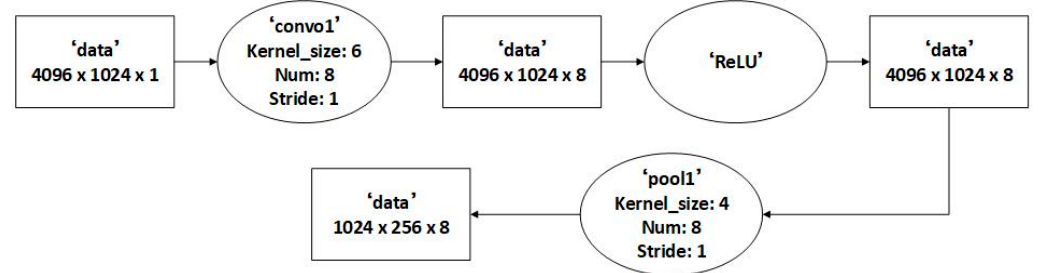
Figure 5. Convo1 convolutional layer process.